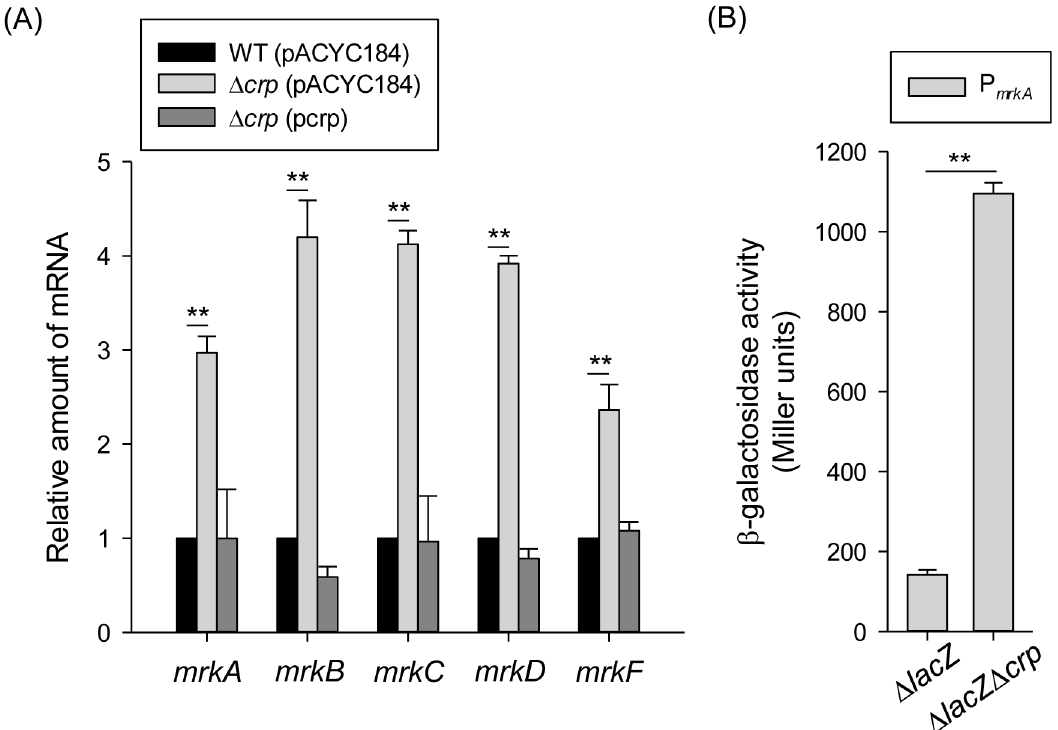
Fig 2. CRP-cAMP affects the type 3 fimbriae expression. (A) qRT-PCR analyses of the mrkA , mrkB , mrkC , mrkD , and mrkF expressions for WT (pACYC184), Δ crp (pACYC184), and Δ crp (pcrp) strains in LB medium. (B) β -galactosidase activities of K . pneumoniae CG43S3 Δ lacZ and the isogenic strain ( Δ lacZ Δ crp ) carrying the reporter plasmid pmrkAZ15 (P mrkA :: lacZ) were determined using log-phase cultures grown in LB medium. The results are representative of three independent experiments. Error bars indicate standard deviations. * P < 0.05 and ** P < 0.01 compared to WT (pACYC184) (A) and CG43S3 Δ lacZ (B) strain.